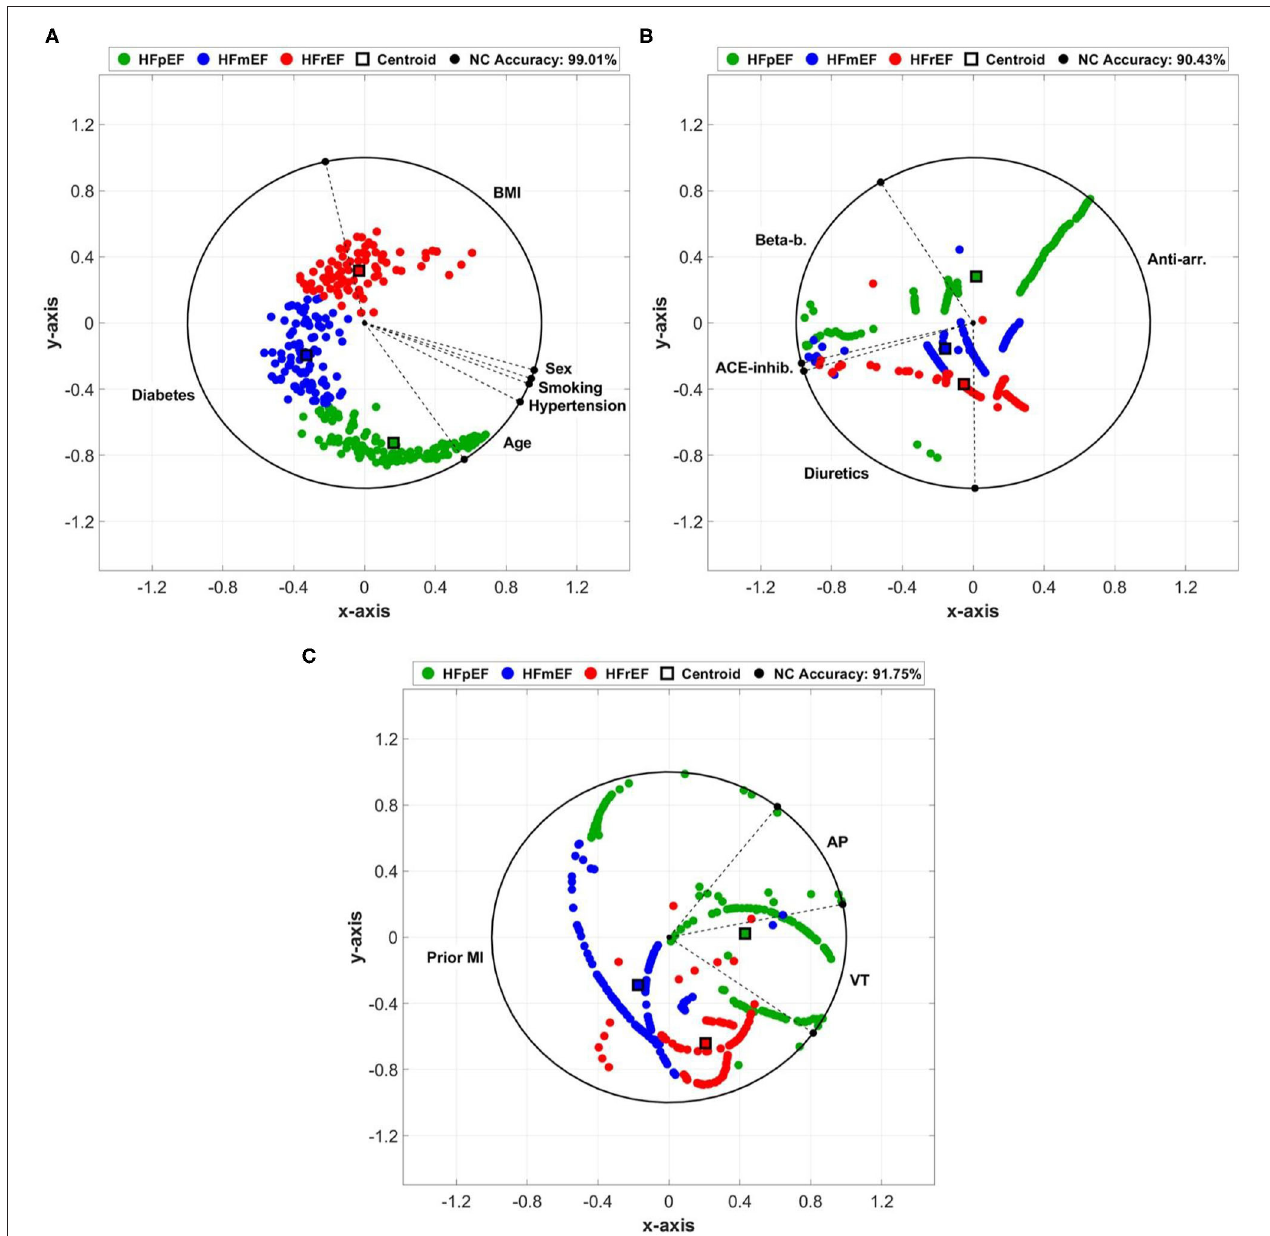
FIGURE 3 | Arc visualization (ArcViz) and dimensionality reduction for: (A) cardiovascular risk factors, (B) cardiovascular medication, and (C) cardiovascular history clinical markers. The nearest centroid (NC) accuracy was calculated after optimizing linear discriminant analysis (LDA) fitting.